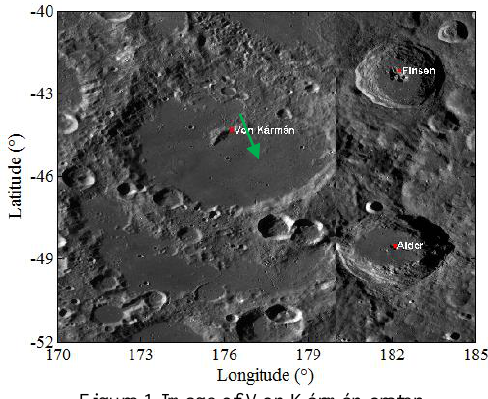
Figure 1 Image of Von Kármán